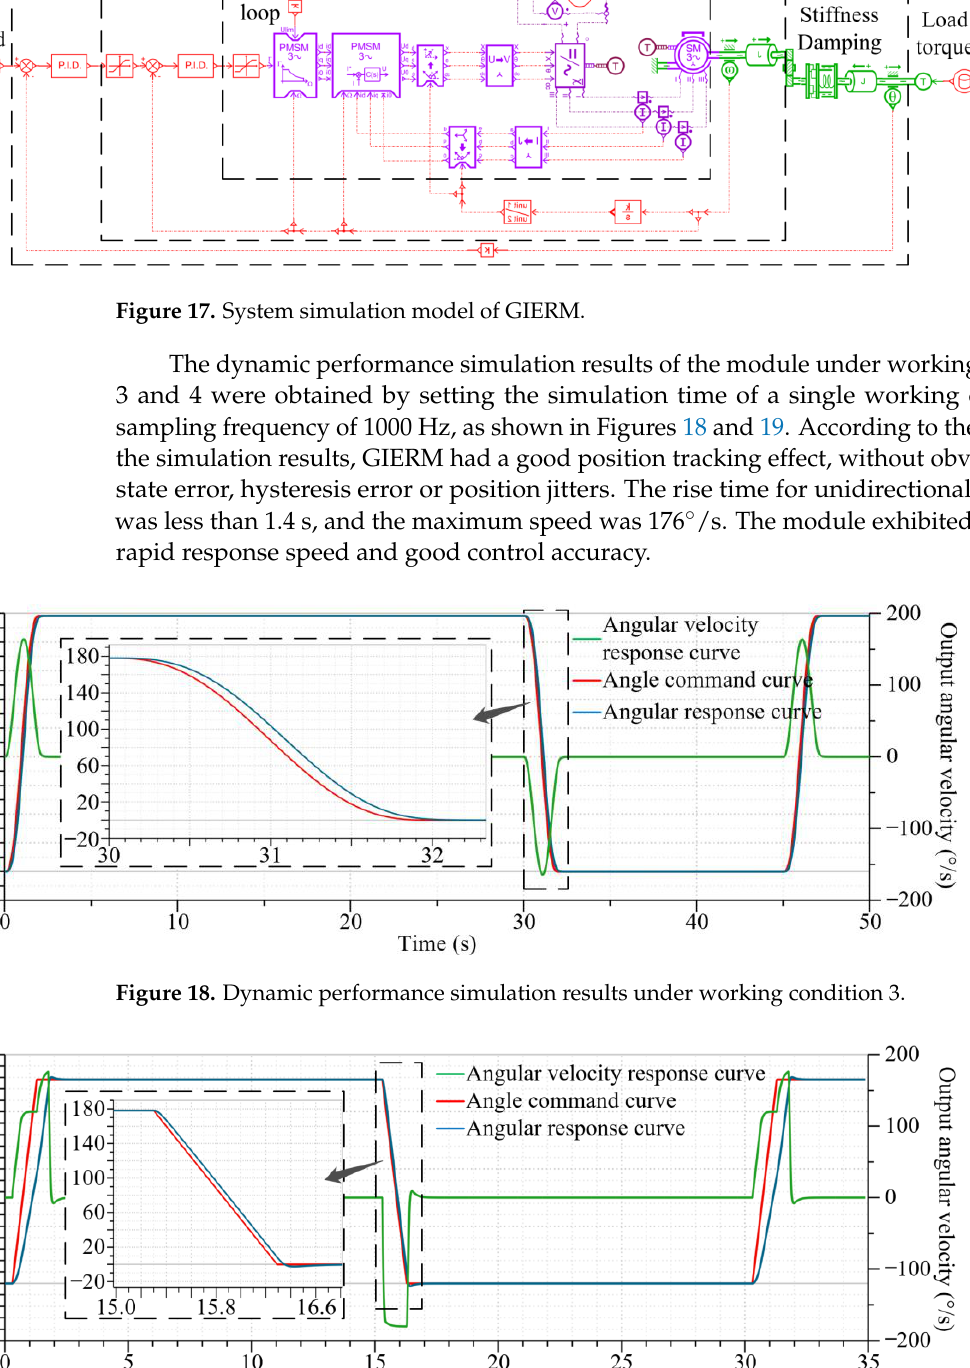
Figure 19. Dynamic performance simulation results under working condition 4.